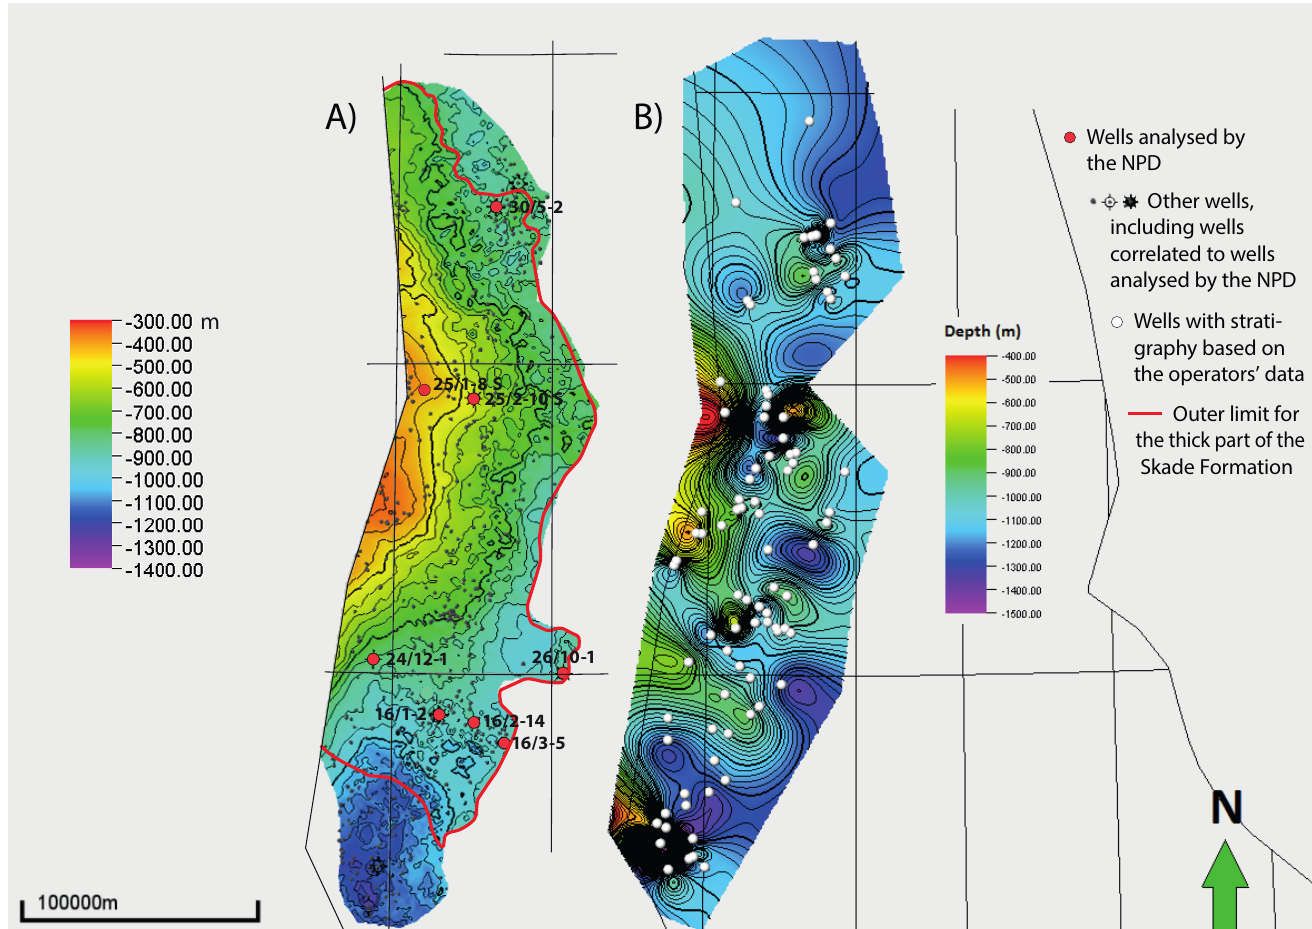
Figure 4. Figure showing (A) a compilation of the depth to the top of the Skade Formation based on NPD’s own well data with (B) a map based on well data obtained by the oil companies’ contracted consultants (modified after Eidvin & Rundberg, 2016b;